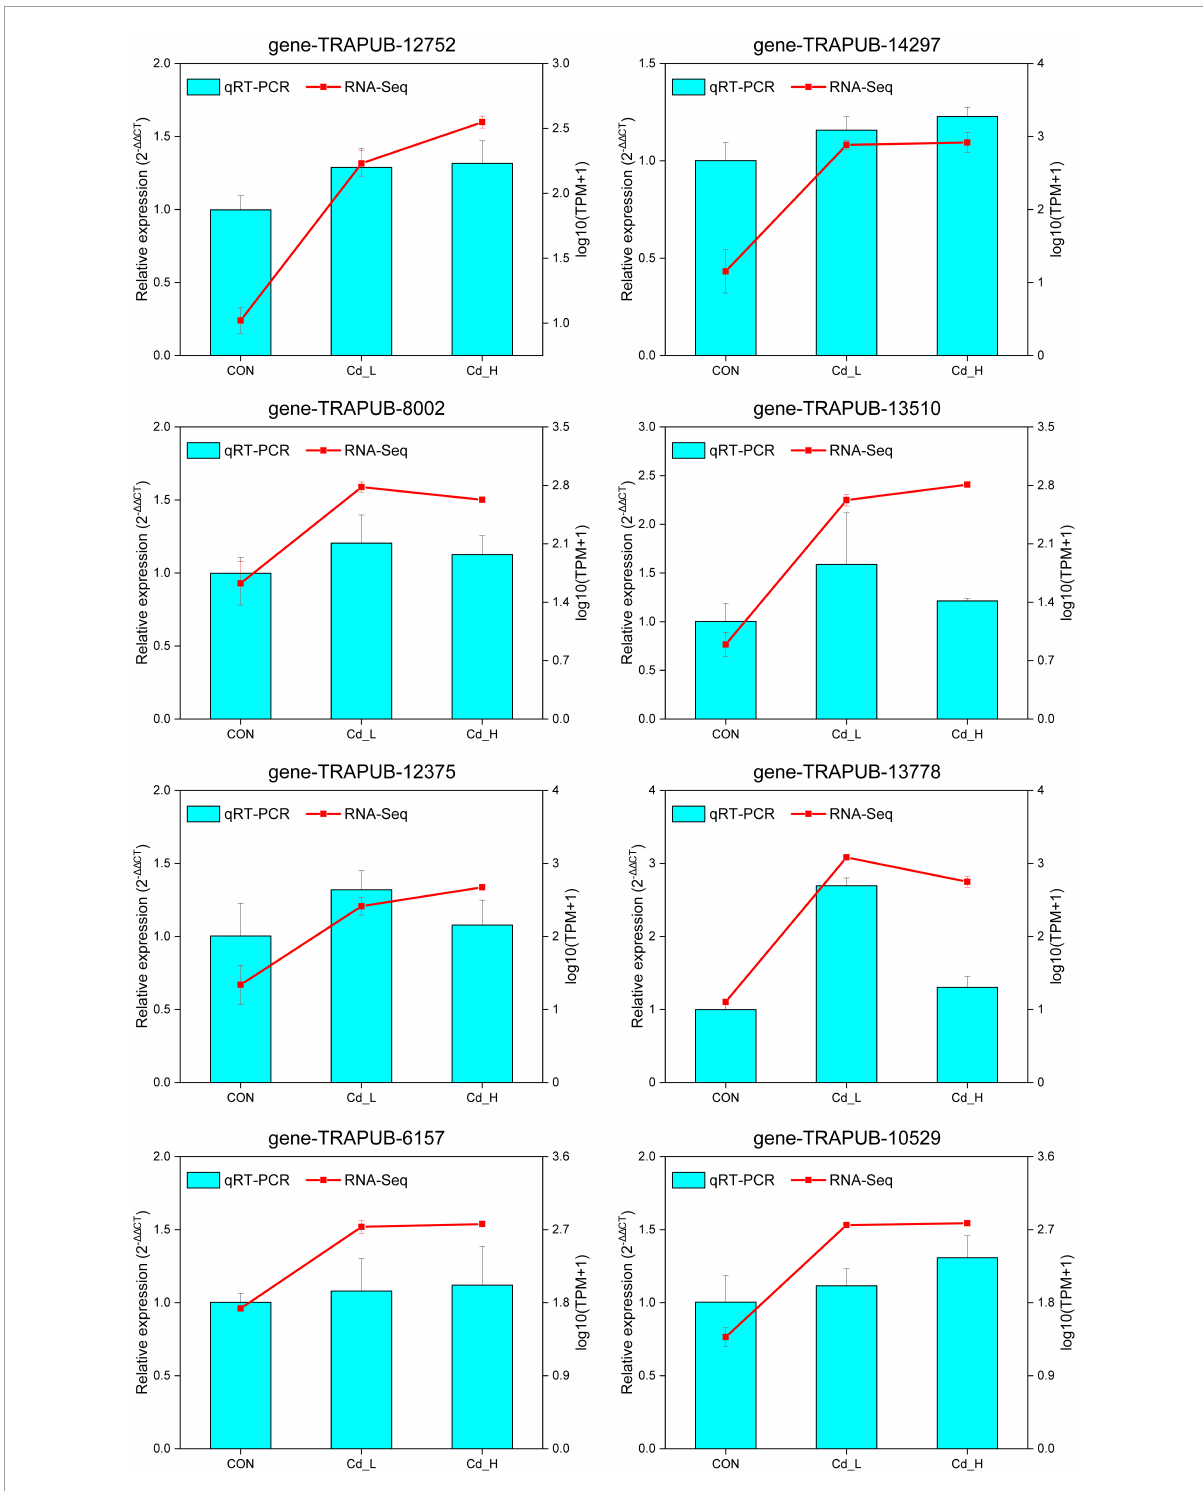
FIGURE8 qRT-PCR verification of the DEGs in T. pubescens under different concentrations of Cd 2 + stress. Comparison of the relative expression levels determined via qRT-PCR and RNA-Seq. Eight genes were selected, including gene-TRAPUB-12752, 14297, 8002, 13510, 12375, 13778, 6157, and 10529. The qPCR expression levels were calculated as a ratio relative to the level of expression in the group of CON, which was set as 1. All data indicate the mean ± SE, with three biological replications and three technical replications. Cd_L, low-dose Cd treatment group; Cd_H, high-dose Cd treatment group; CON, no Cd treatment group; qRT-PCR, real-time quantitative PCR; DEGs, differentially expressed